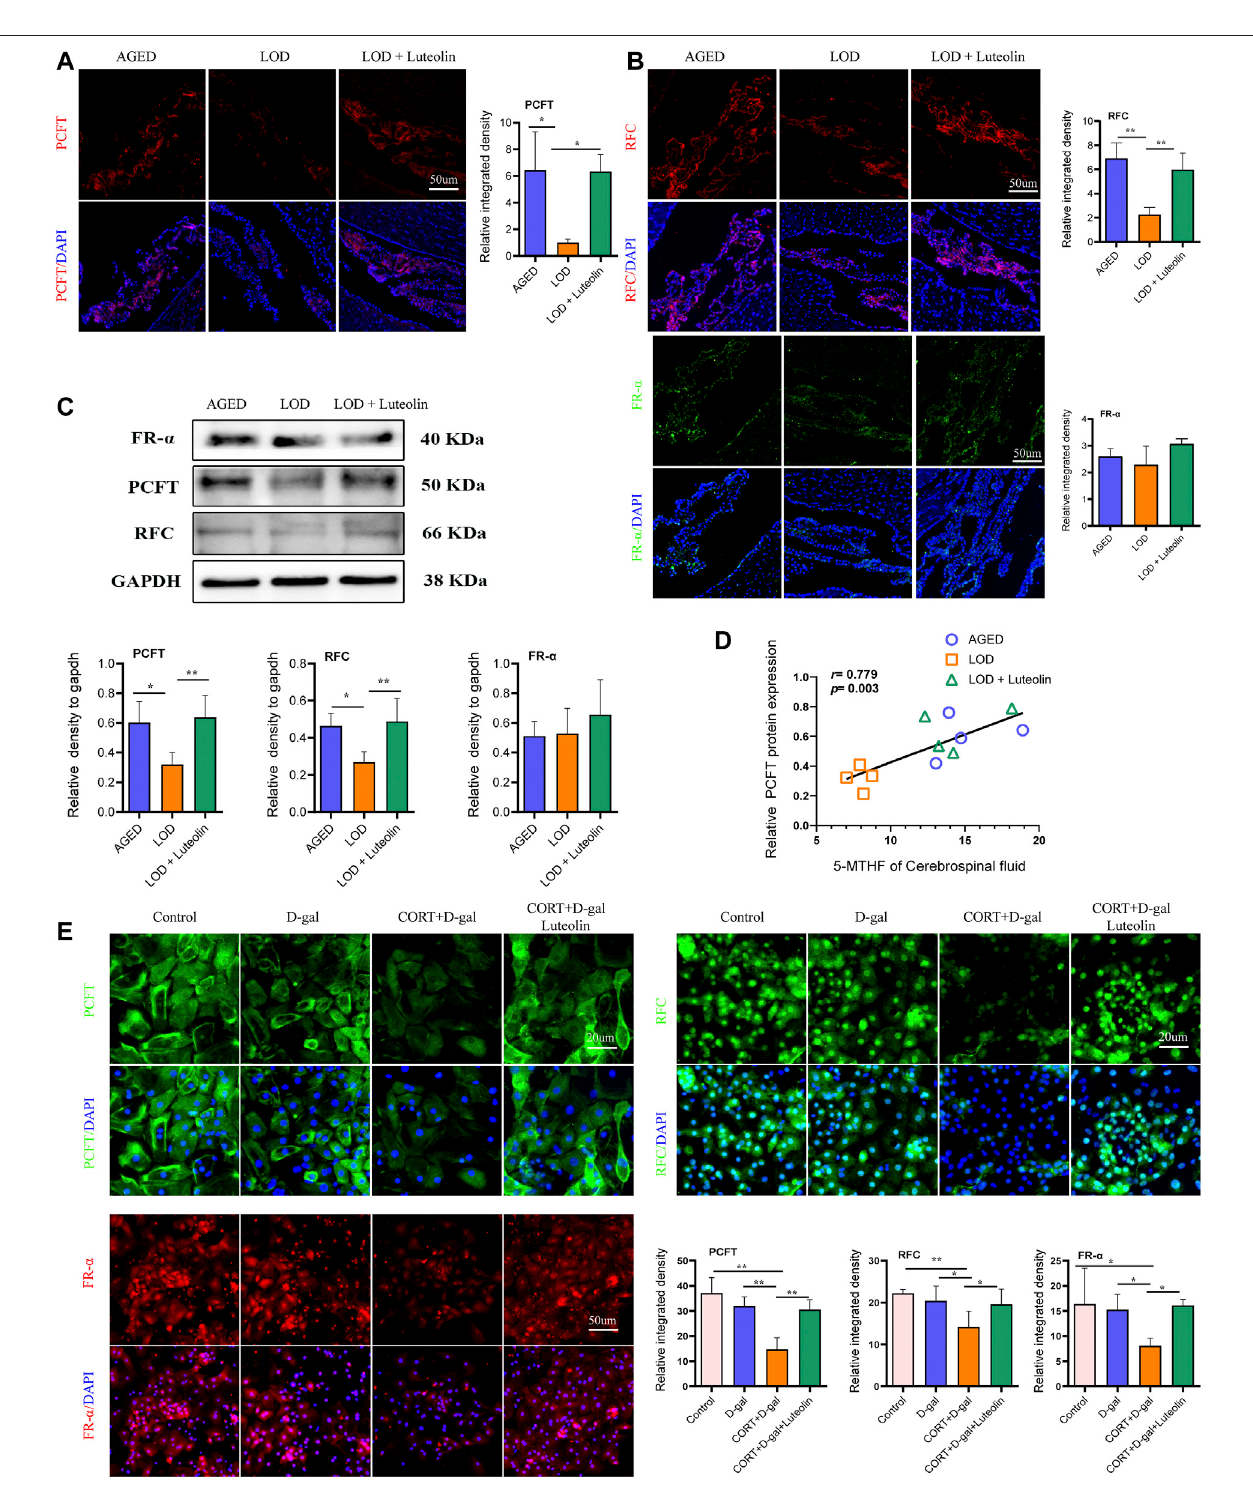
FIGURE7| EffectsofluteolinonthelevelsofPCFT,RFC,andFR- α intheCPandratCPECs.Immuno fl uorescenceimagesofPCFT,RFC,andFR- α intheCP (A,B) ( n =3). RepresentativeWestern blotting imagesofPCFT, RFC,and FR- α levelsinthe CP (C) ( n =4). Correlations betweenCSF5-MTHF andPCFT protein levels (D) ( n = 4), respectively. Immuno fl uorescence images of PCFT, RFC, and FR- α in rat CPECs (E) ( n = 4). Data in each group were consistent with a normal distribution (Shapiro – Wilk test) and exhibited homogeneity of variance; one-way analysis ofvariance was then used for comparisons. Data are expressed as the mean ± SEM, * p < 0.05, ** p < 0.01 vs. LOD or CORT + D-gal.